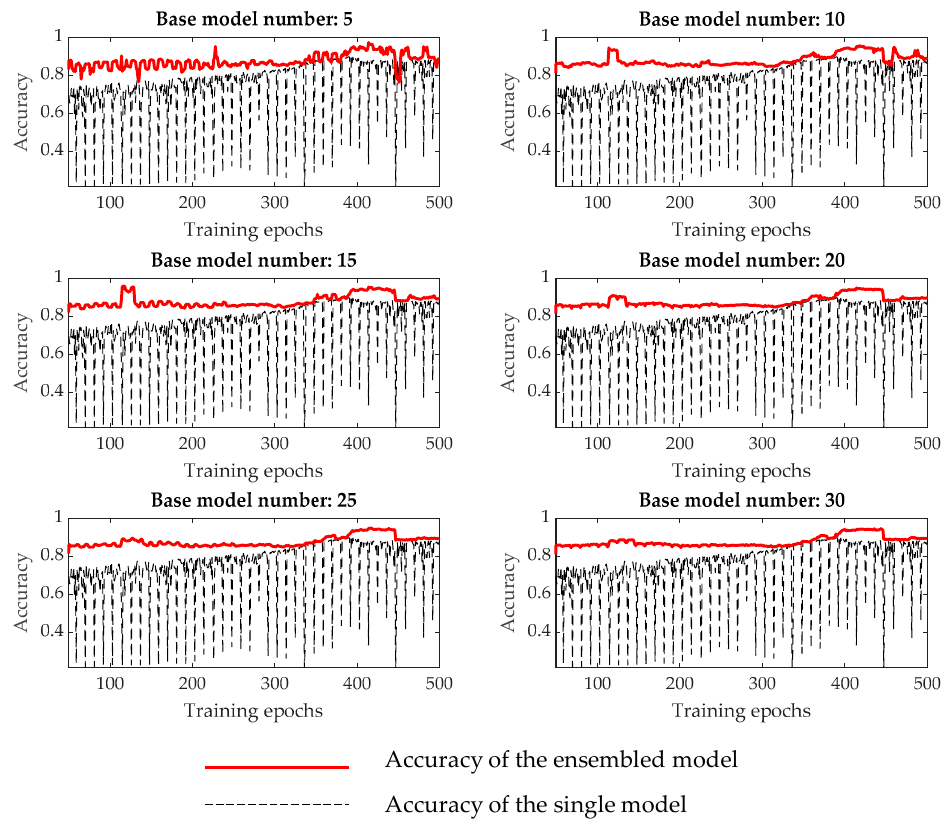
Figure 14. Comparison analysis of the ensembled and single convolutional GAN.